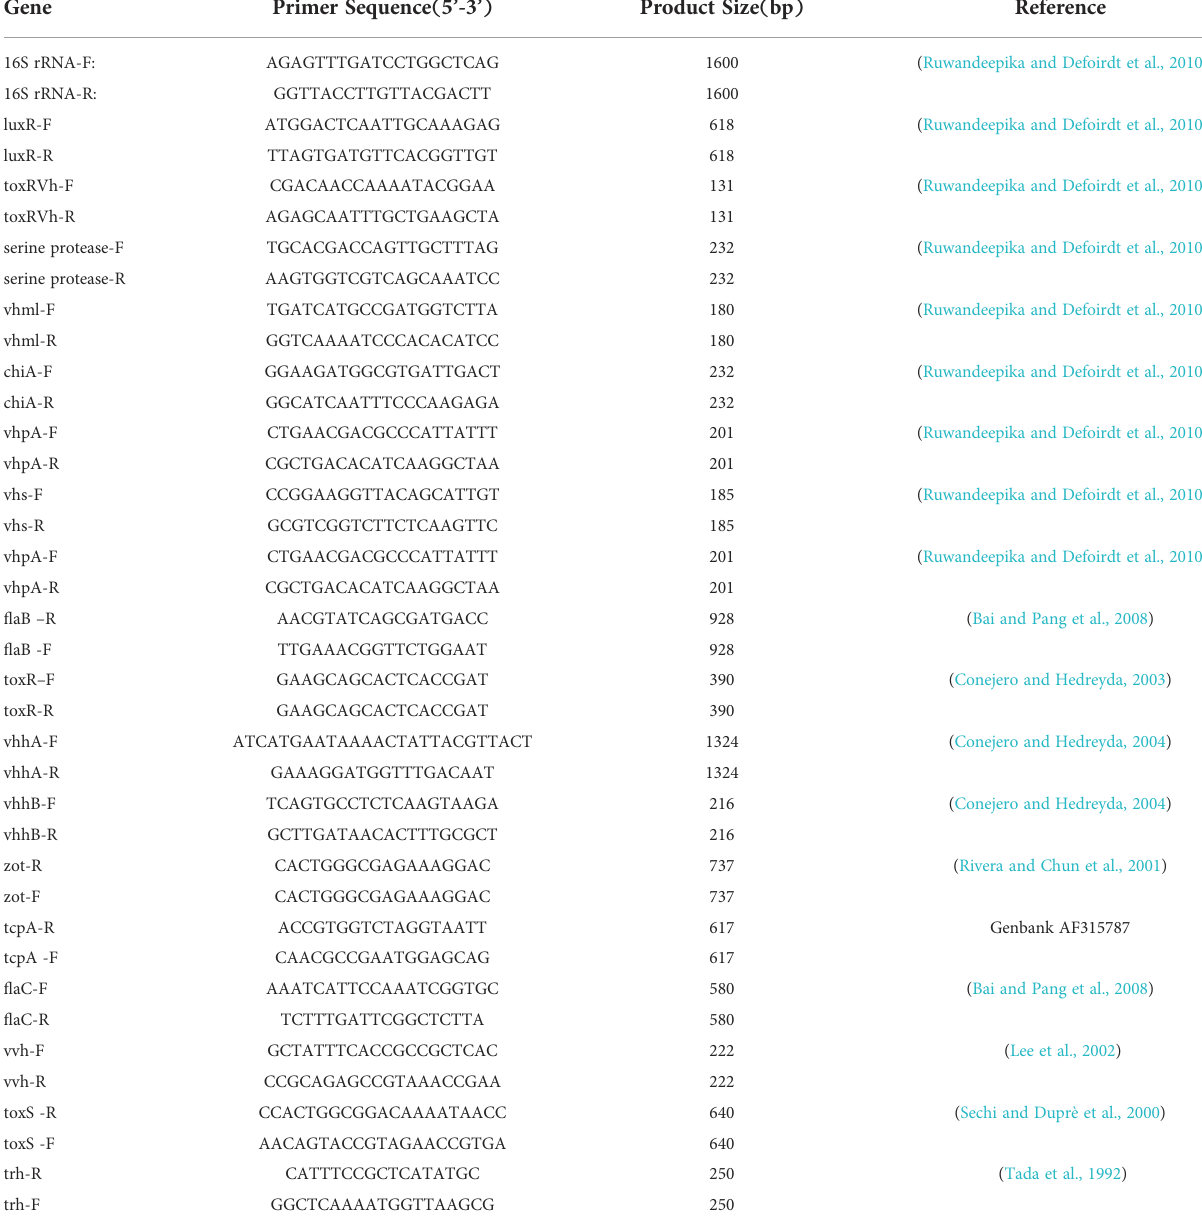
TABLE 1 List of primers used for ampli fi cation of 16S rRNA gene and virulent genes. Gene Primer Sequence （ 5 ’ -3 ’ ） Product Size （ bp ）